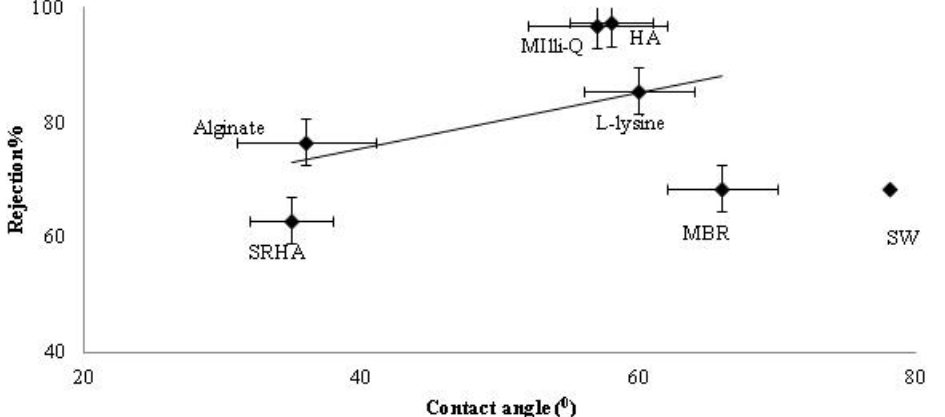
Figure 7. Rejection of risperidone by HA, alginate, lysine, SRHA and surface water fouled NF270 vs. fouled membranes contact